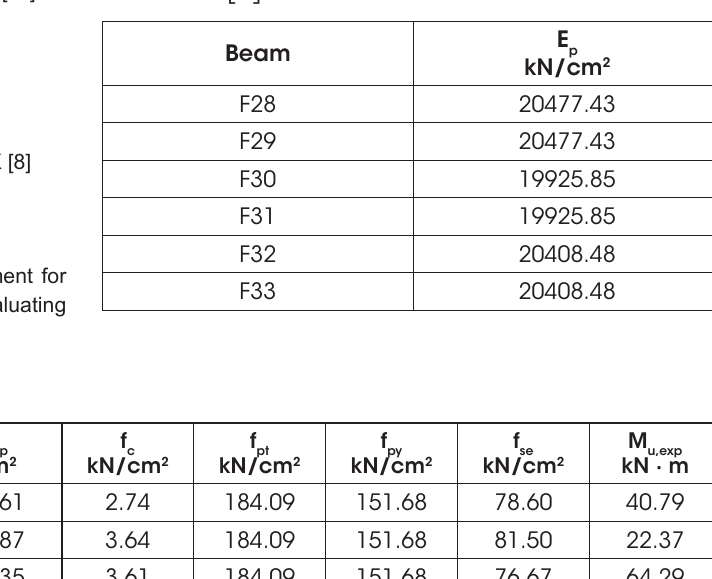
Table 6: Additional data for the beams tested by TAO e DU [11]